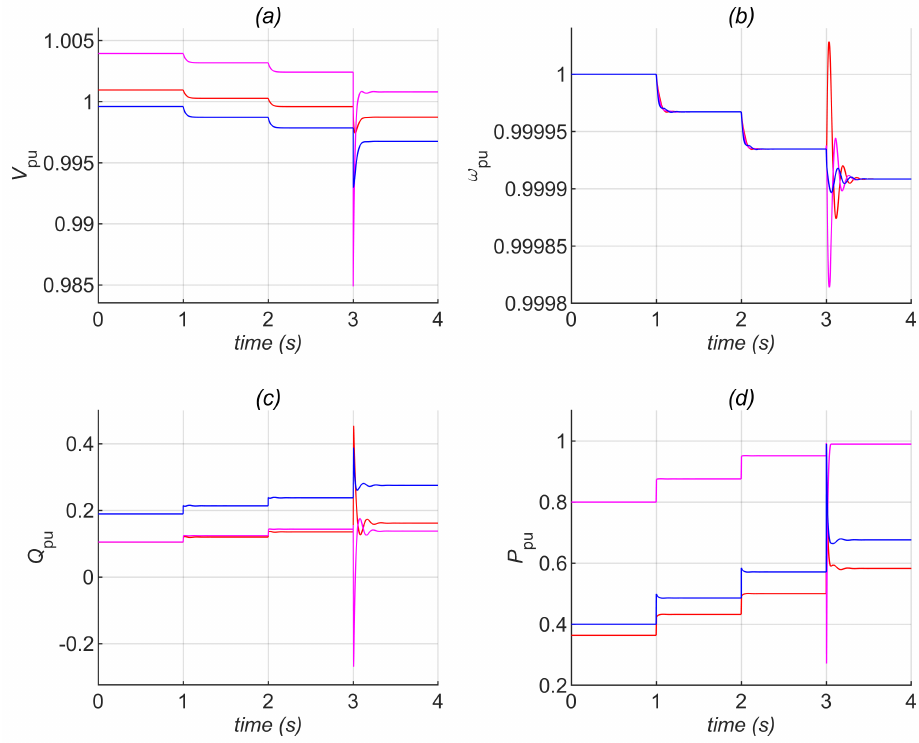
Figure 5. ( a ) Bus Voltages, ( b ) Frequency, ( c ) Reactive Power Output, ( d ) Active Power Output, with Jacobian and PFT; at VSI Buses (1—red, 2—magenta,